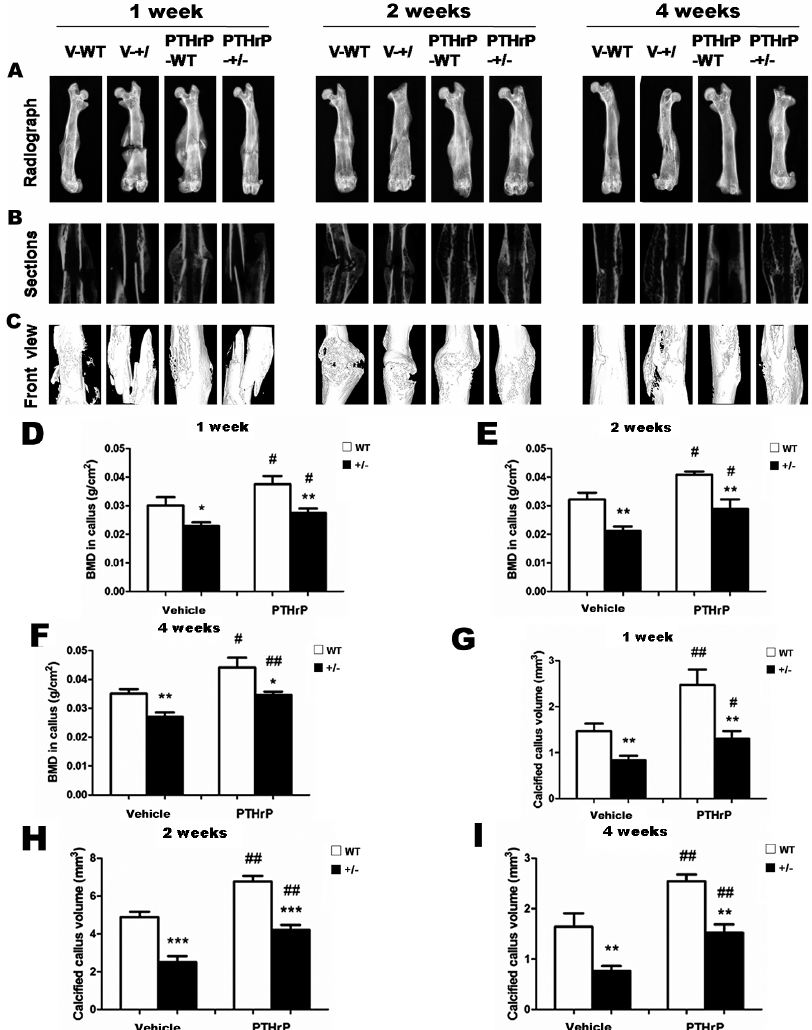
Figure 1. Exogenous parathyroid hormone-related protein (PTHrP) improves bone healing radiographic parameters in both wild-type (WT) and PTHrP-KO (knock-out) mice. Representative micrographs of callus sections and areas of the total callus from Vehicle (V)-WT, Vehicle-KO, PTHrP-WT, and PTHrP-KO mice at one, two, and four weeks post-fracture (PF) ( A – C ). Bone mineral density (BMD) ( D – F ) and calcified callus ( G – I ) were measured by computer-assisted image analysis.at one, two, and four weeks PF. Error bars are mean + SEM (standard error of mean). * p < 0.05; ** p < 0.01 and *** p < 0.001 compared with WT mice. # p < 0.05 and ## p < 0.01 compared with genotype-matched V-treated mice.